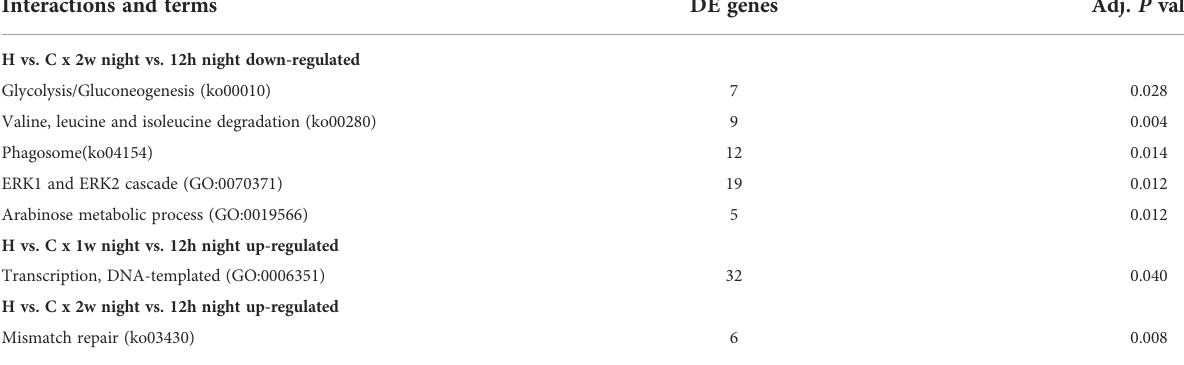
TABLE 2 Time-dependent changes in transcriptional response to deoxygenation, in S. pistillata . Interactions and